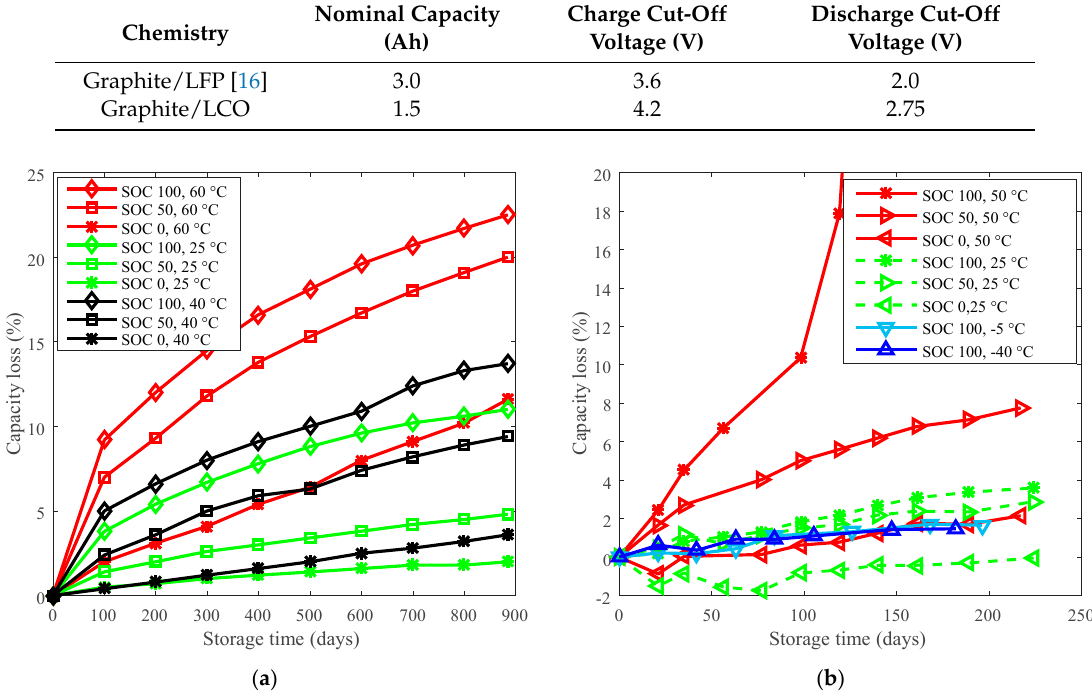
Figure 1. Calendar life testing data. (a) LiFePO4 (LFP) batteries were tested under three temperatures (60 °C, 40 °C, and 25 °C) and three state of charges (SOCs) (100%, 50%, and 0%) with an experiment